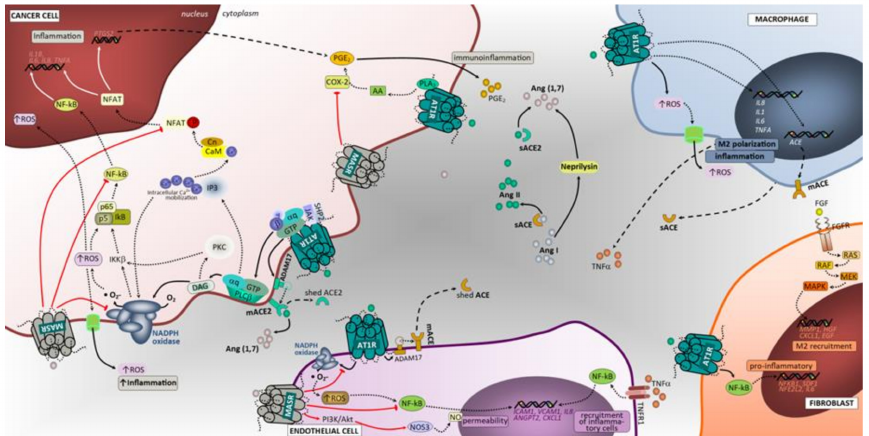
Figure 4. Angiotensin-associated immunoinflammatory pathways in lung tumor microenvironment. Extracellular proteins of the RAS, ligands (Ang I, Ang II and Ang 1,7) and enzymes (ACE, ACE2 and neprilysin), are represented with distinct colors in the tumor microenvironment. The expression and cleavage of ACE and ACE2 are represented in tumor and endothelial cells, showing the AT1R signaling-associated activation of ADAM17 that cleaves the ectodomain of mACE and mACE2 shedding the enzymes into sACE and sACE2. The Ang II / AT1R-mediated direct intracellular signaling is represented with full black arrows as a first step after AT1R triggering in the cascade. The subsequent steps of signaling cascades are depicted, up to moving towards intranuclear space, using dashed black arrows. Intranuclear signaling from these pathways mainly results in transcriptional regulatory e ff ects and is represented by full white arrows. The Ang II / AT2R and Ang (1,7) / MasR-mediated counter-regulatory mechanisms are depicted using black arrows and when adequate the suppressive step is represented by blunt-ended red arrows. In cancer cells, upon binding of Ang II to AT1R, a pleiotropic downstream signaling cascade is triggered, ultimately causing, either directly or indirectly inflammation immune cells recruitment. Activated AT1R triggers potent oxidant signaling through NADPH complex, which is involved in inflammation and angiogenesis. Other intracellular cascades mediated by Ang II / AT1R include the activation of PLA2 / AA / COX-2 / PGE2 signaling. The Ang (1,7) / MasR activation elicits downstream signaling through PI3K / Akt / NOS3 or NOS1 to produce NO that inhibits NFAT transcriptional regulation that reduces inflammation. Notably, this pathway blocks the NF-kB molecule formation thereby impacting inflammation. In addition, the inhibitory e ff ect over COX-2 significantly impact inflammation. Macrophages, endothelial cells and fibroblasts are important components of the tumor microenvironment and capable of generating and expressing RAS components. These cells, beyond their functional ligands and receptors that are altered in tumor microenvironment, and reflect the crosstalk between all cell constituents, also use the RAS signaling pathway (mostly AT1, but also MasR in endothelial cells) to yield functional characteristics that ultimately may favor the cell itself and enhance tumor growth and aggressiveness. PLA2, phospholipase A2; PTP, protein tyrosine phosphatase; PP2A, Protein phosphatase 2; IKKB, Inhibitor of nuclear factor kappa-B kinase subunit beta; CARMA3, CARD recruited membrane associated protein 3; MALT1, Mucosa-associated lymphoid tissue lymphoma translocation protein 1; BCL-10, B-cell lymphoma / leukemia 10; c-SRC, cellular Proto-oncogene tyrosine-protein kinase; SHP2, Src homology region 2 domain-containing phosphatase-2; AA, arachidonic acid; COX-2, cyclooxygenase 2; PGE2, prostaglandin E2; IL1, interleukin 1; TNFA, tumor necrosis factor; Ang I, angiotensin I; Ang II, angiotensin II; GTP, guanosine triphosphate; EGF, epidermal growth factor; EGFR, epidermal growth factor receptor; ANGPT2, angiopoietin 2; ICAM1, Intercellular Adhesion Molecule 1; VCAM1, vascular cell adhesion molecule 1 ; CXCL1, The chemokine (C-X-C motif) ligand 1; IL8, interleukin 8; NF-kB, Nuclear Factor-kappa B; NFKB1, Nuclear Factor-kappa B Subunit 1; IL6, interleukin 6; NFE2L2, Nuclear Factor, Erythroid 2 Like 2; HGF, hepatocyte growth factor; RAS, oncogene protein p21; ROS, reactive oxygen species; NOS3, nitric oxide synthase 3 endothelial; NOS1, nitric oxide synthase 1